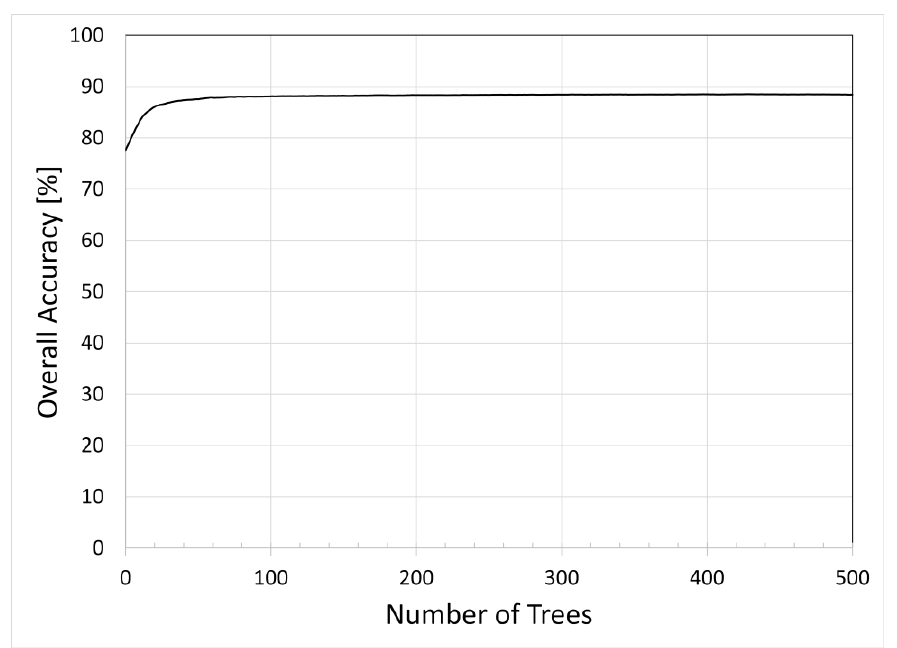
Figure 6. Learning curve (out-of-bag-accuracy) for 2001